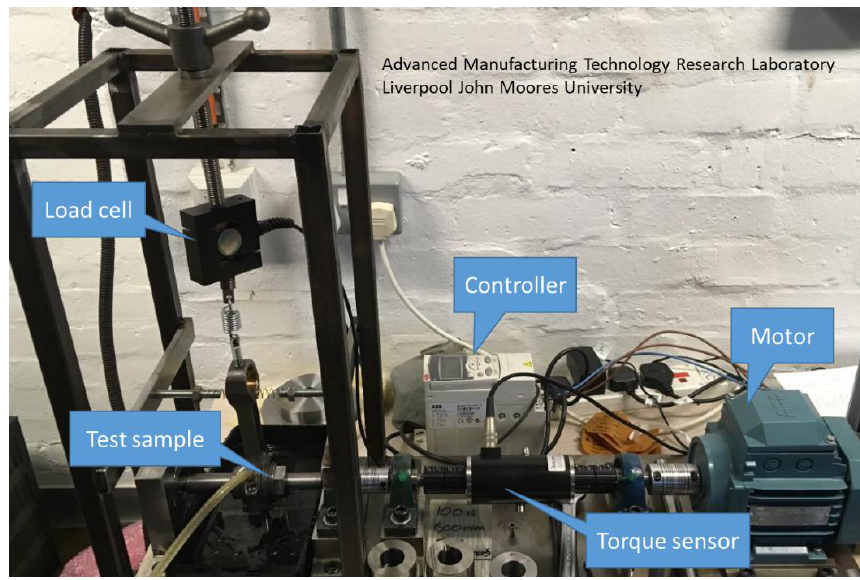
Figure 3. The friction test rig setup.